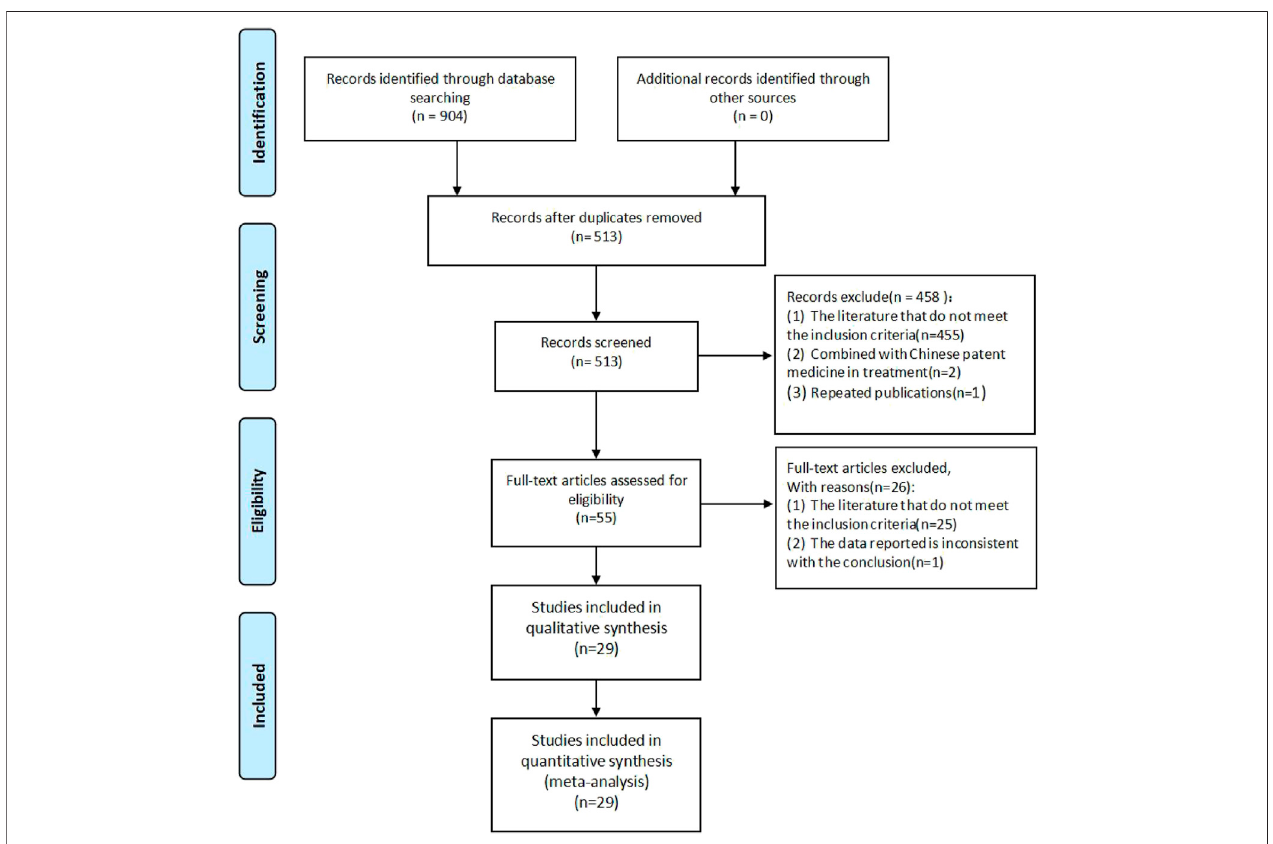
FIGURE 1 | Flow diagram of literature screening